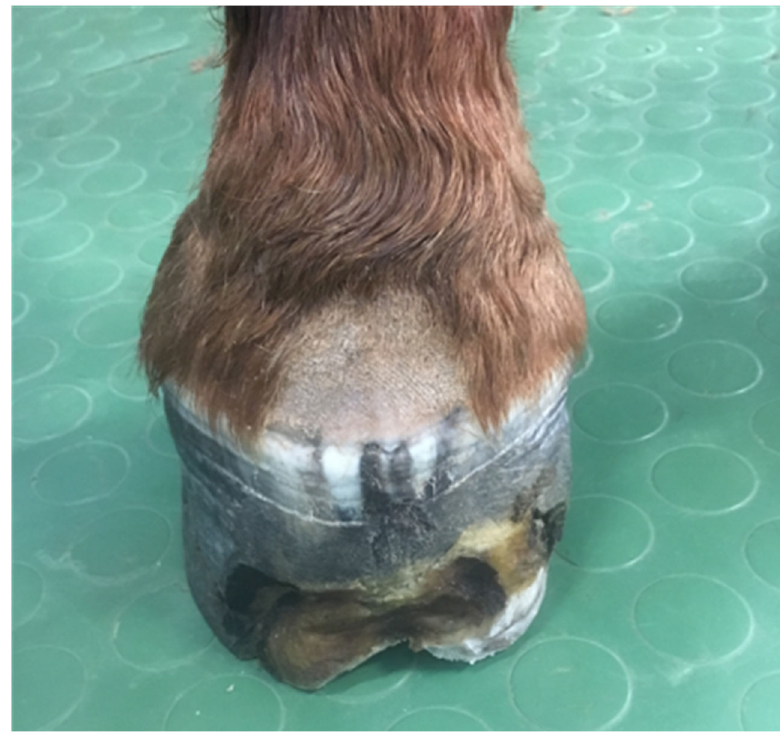
Figure 6. Hoof 116 days after